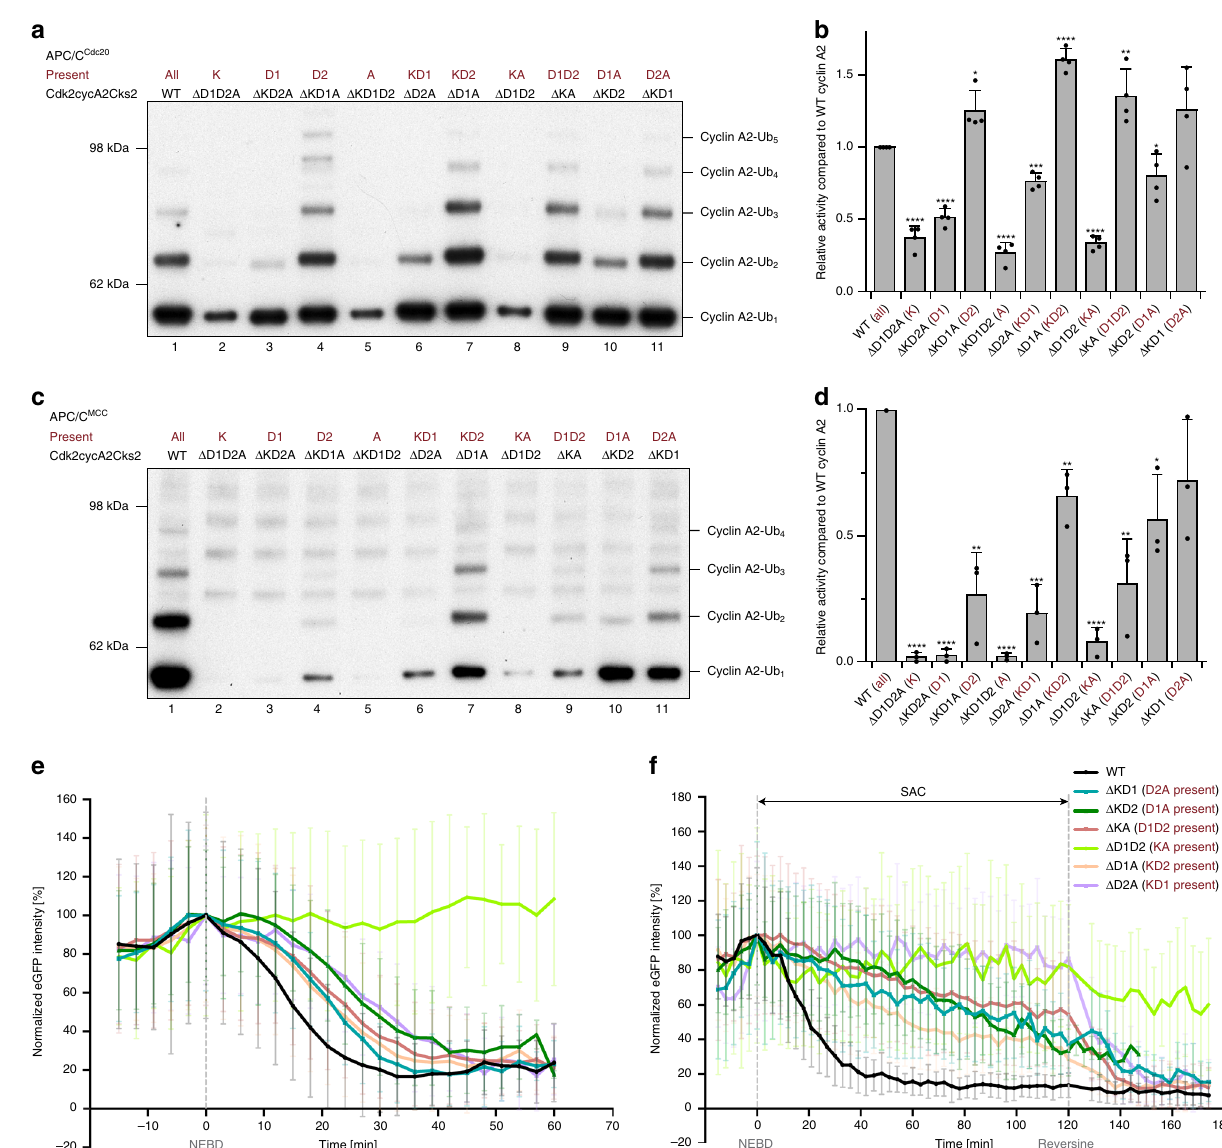
Fig. 5 A cooperation of multiple degrons confers the resistance of cyclin A2 to MCC-imposed inhibition. a – d Ubiquitination assays of double and triple degron mutations in cyclin A2 by APC/C Cdc20 ( a ) and APC/C MCC ( c ). In all assays, cyclin A2 is in complex with Cdk2-Cks2. The D2 box is the critical determinant for cyclin A2 ubiquitination by APC/C Cdc20 (compare lanes 1, 4, 7, 9 and 11 in a ). To resist MCC-mediated inhibition, cyclin A2 requires both the KEN box and ABBA motif together with the D2 box (compare lanes 1, 7 and 11 in c ). The remaining degrons in cyclin A2 after the mutation are labelled in dark red. Ubiquitination reactions were analysed by western blotting with an anti-His antibody to detect the His-tag of the ubiquitin-modi fi ed substrates. Control gels indicating the unmodi fi ed substrate for representative reactions are shown in Supplementary Fig. 2. The western-blots were quanti fi ed to show the effect of individual mutations, with error bars indicating standard deviation. The APC/C activity towards cyclin A2 mutants is normalized to ubiquitination of wild-type cyclin A2 and signi fi cance is calculated using unpaired Student ’ s t-test (indicated with stars, n = 4 for b and 3 for d , Supplementary Table 2). e , f Degradation pro fi les of the eGFP-cyclin A2 double degron mutants in HEK cells under unperturbed mitosis ( e ) and a SAC arrest using STLC ( f ). The total eGFP fl uorescence minus background fl uorescence for each cell at each time point was normalized to NEBD, quanti fi ed and plotted over time. The timepoints of NEBD and reversine addition to release the SAC arrest are marked, respectively. Error bars indicate mean ± standard deviation of n = 62 wild-type, 33 Δ KD1, 58 Δ KD2, 34 Δ KA, 28 Δ D1D2, 48 Δ D1A and 23 Δ D2A cells under unperturbed mitosis and 13 wild-type, 15 Δ KD1,